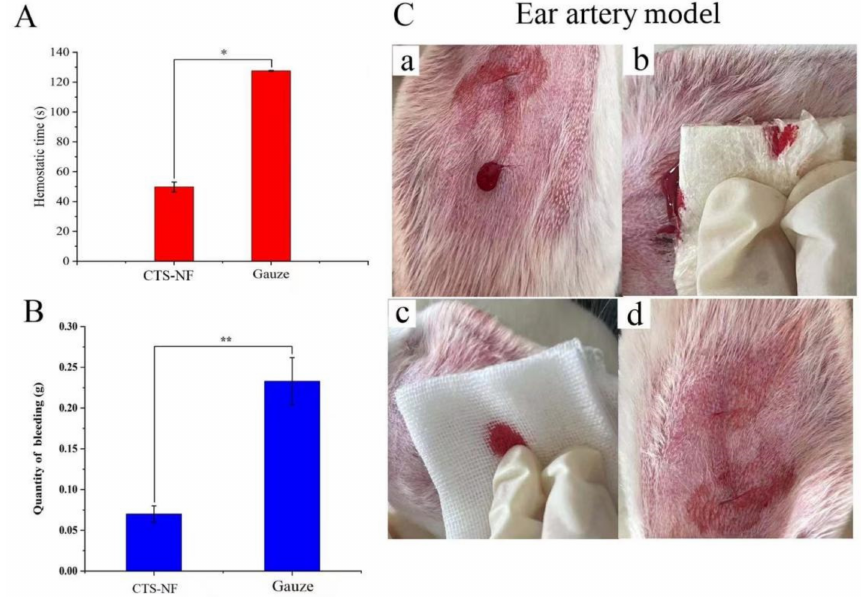
Figure 10. ( A ) The hemostasis time of the ear and ( B ) the amount of bleeding. ( C ) Ear artery hemostasis: bleeding ( a ), CTS-NF sponge hemostasis ( b ), medical gauze hemostasis ( c ), CTS-NF sponge wound ( d ). * p < 0.05, ** p < 0.01 indicates significant difference from the control